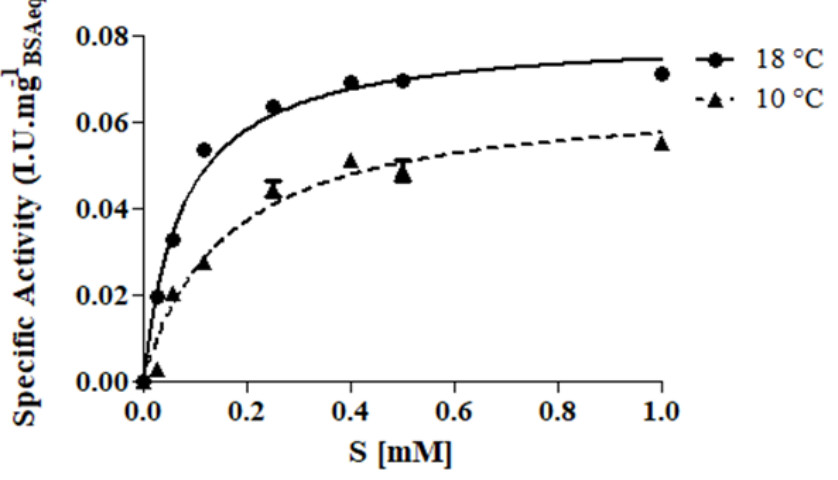
Figure 1. Kinetic curves of protease tested at two different temperatures: 10 °C ( ▲ , cold settling prior to AF) and 18 °C ( ● , AF). Assay was performed in model wine-must (tartaric buffer 0.3 M, pH